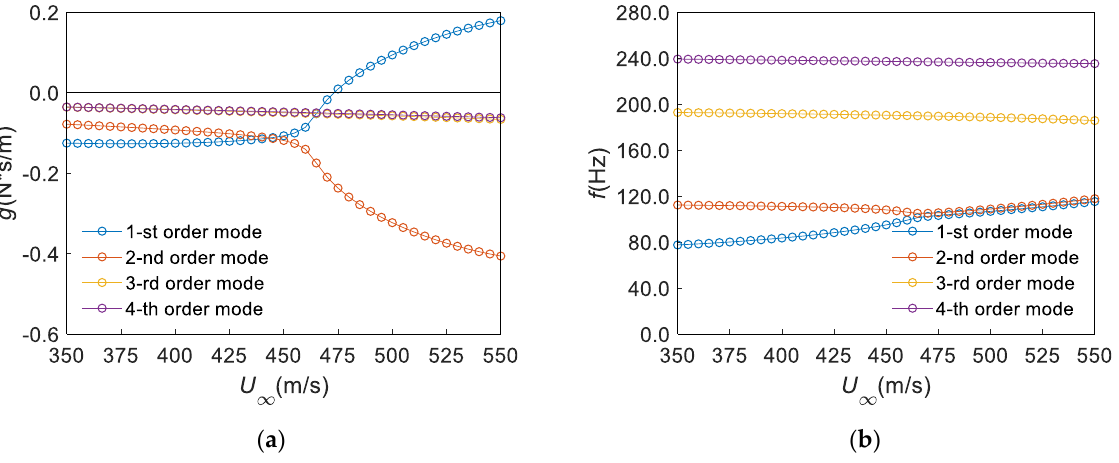
Figure 25. Results of flutter calculation for the panel with no mass attachment (QP) (